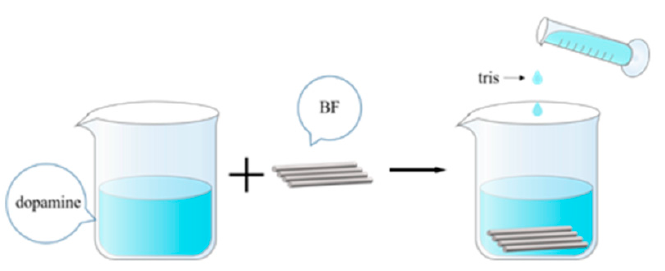
Figure 1. Flow chart of PDA modified BF.